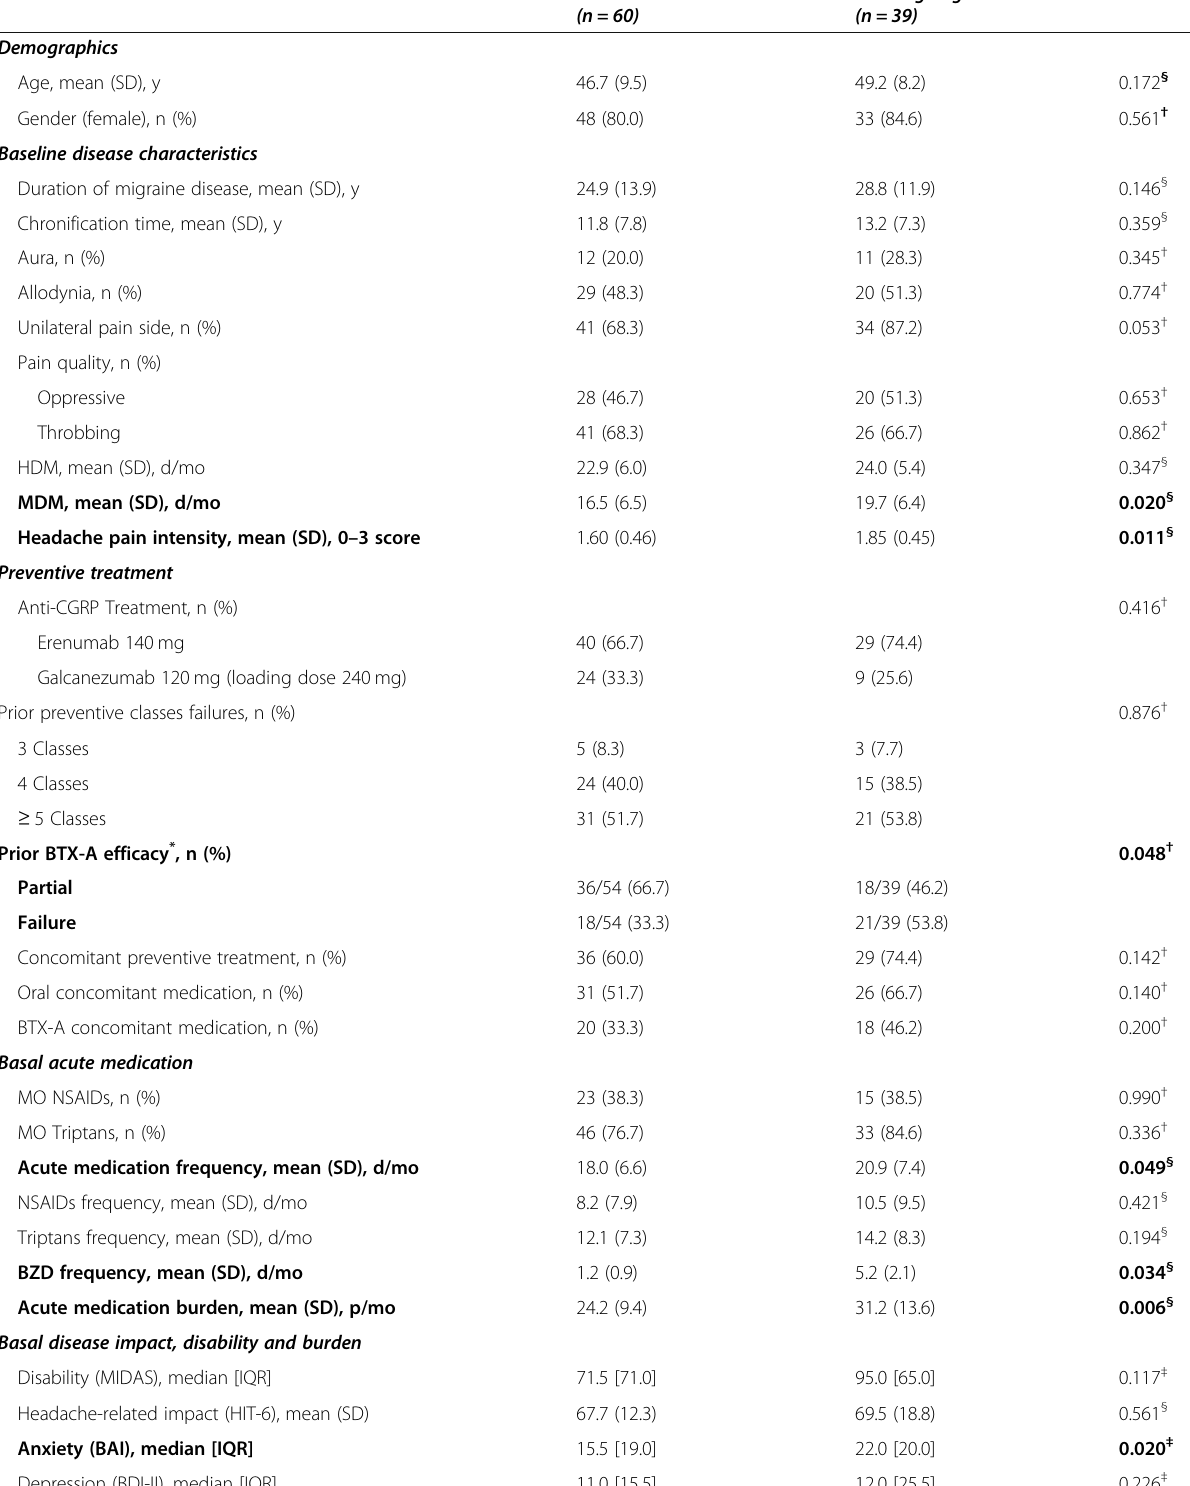
Table.1 Baseline characteristics and their association with medication overuse resolution after 6 administrations of anti-CGRP